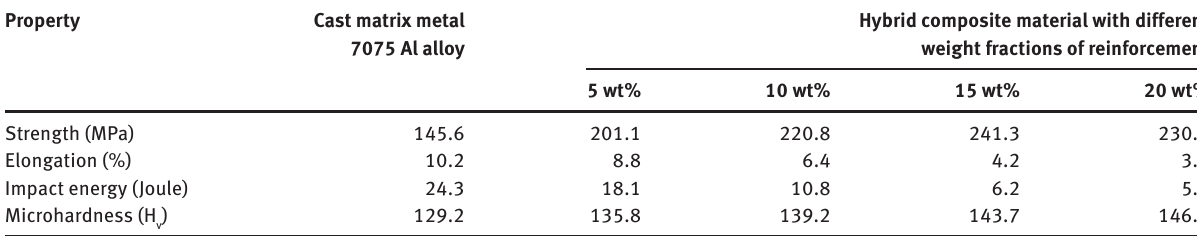
Table 3: Tensile strength, % elongation and impact energy of matrix alloy and hybrid metal matrix composite (MMC). Property